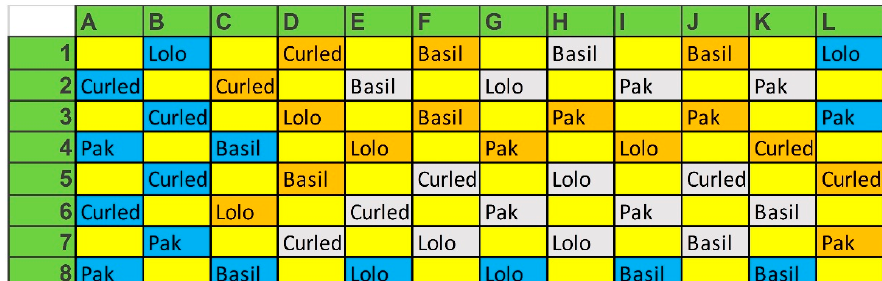
Figure 5. Planting plan of the production levels based on a randomized block design with three photosynthetic photon flux density (PPFD) level: 185.2 µmol m − 2 s − 1 (blue); 355.7 µmol m − 2 s − 1 (or- µ mol m − 2 s − 1 (blue); 355.7 µ mol m − 2 s − 1 ange); 466.4 µmol m − 2 s − 1 (grey). Every square represents photosynthetic photon flux density (PPFD) level: 185.2 (orange); 466.4 µ mol m − 2 s − 1 (grey). Every square represents one planting space (Curled: